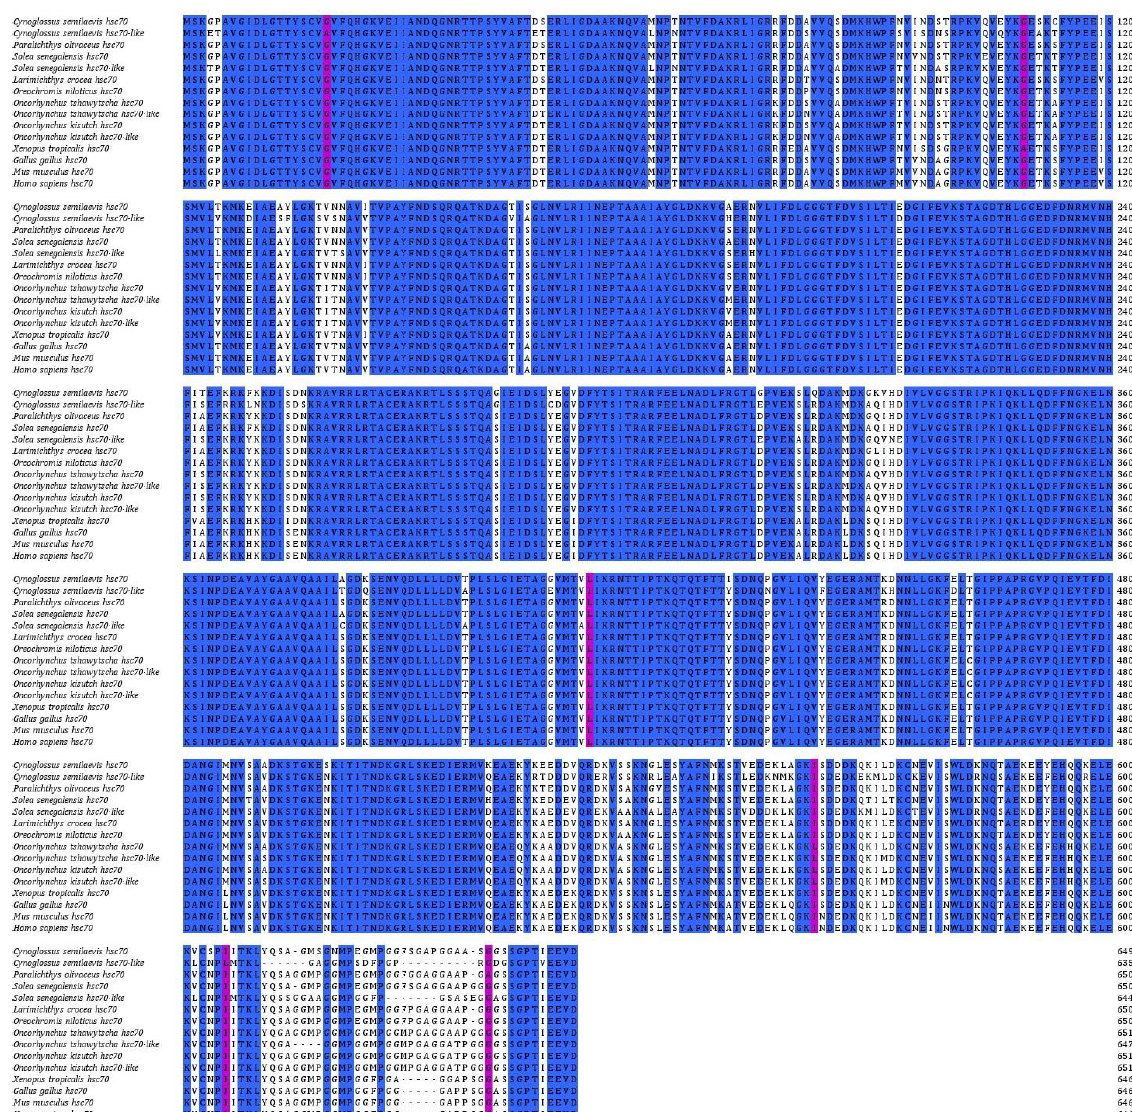
Figure 2. Multiple sequence alignment of HSC and HSC70-LIKE protein sequences from C. semi- laevis and other vertebrates. GenBank accession numbers for protein sequences were as follows: XP_043872802.1 ( Solea senegalensis ), XP_020363711.1 ( Oncorhynchus kisutch ), XP_042153383.1 ( On- corhynchus tshawytscha ), XP_019941072.1 ( Paralichthys olivaceus ), XP_043897279.1 ( Solea senegalensis ), XP_027129165.1 ( Larimichthys crocea ), XP_003448938.1 ( Oreochromis niloticus ), XP_024298732.1 ( On- corhynchus tshawytscha ), XP_020358882.1 ( Oncorhynchus kisutch ), XP_002937574.2 ( Xenopus tropicalis ), NP_990334.2 ( Gallus gallus ), NP_112442.2 ( Mus musculus ), and XP_011541100.1 ( Homo sapiens ). The pink boxes indicated high similarity, while the blue boxes indicated completely identical residues.